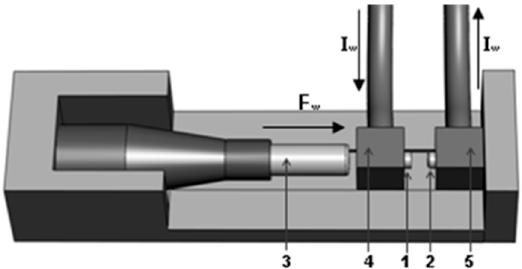
Figure 3. Schematic view of the welding device ( F w = welding force; I w : welding current intensity; 1: end plug; 2: clad; 3: pneumatic jack; 4 and 5: electrodes).